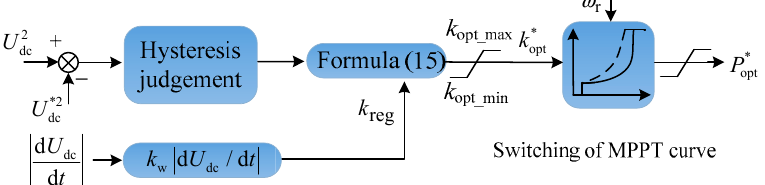
Figure 9. Principle diagram of self-adaptive speed control of wind power system.